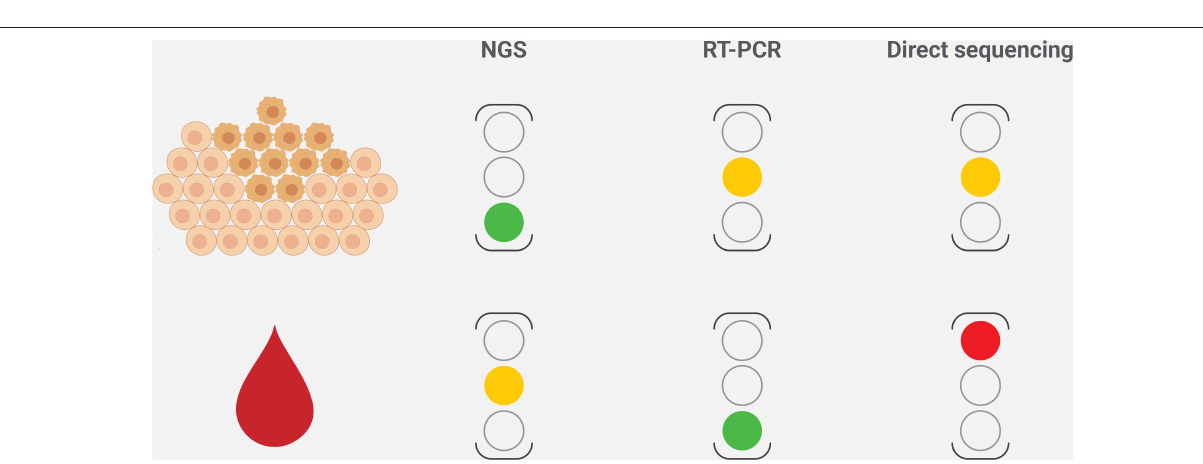
FIGURE 4 | Strengths and limitations of the different methods to characterize PIK3CA mutational status in breast cancer, according to the sample type. The level of caution for each method is reported on the right, where the green light represents to proceed, the amber light represents warning on possible fails or false-negative results, and the red light represents discouraging the use of the technology in that setting. NGS, next-generation